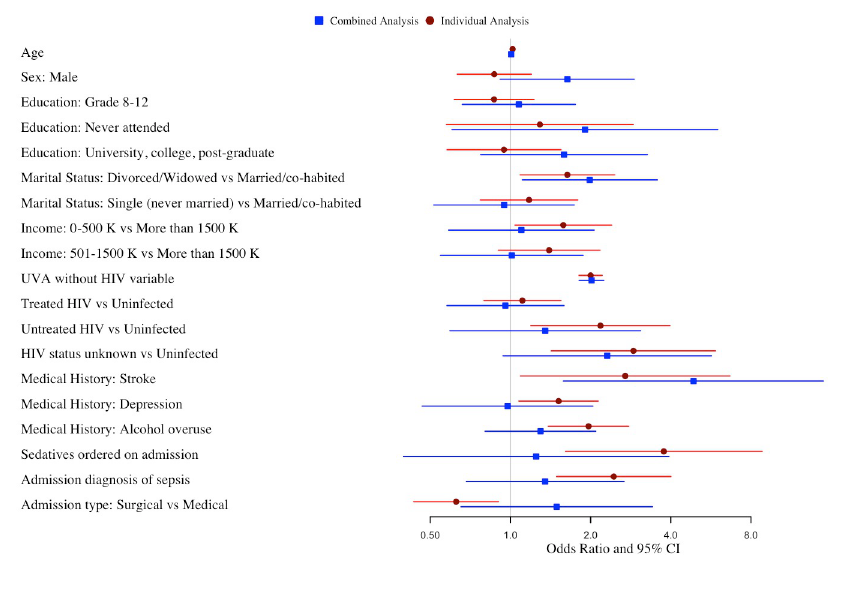
Fig 2. Forest plot comparing results of individual and combined regression